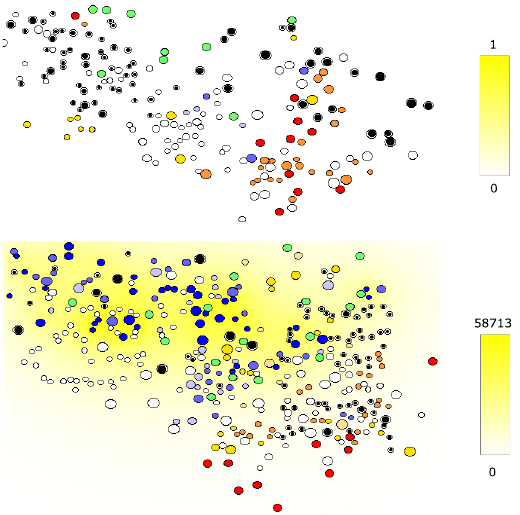
Figure 10. Snapshots of the simulation in which the concentration of FasL (in molecules/ µ L) is shown in yellow color gradient. For cell notations, the same color code as in Figure 7 is used. ( top ) Three days after the virus transmission; ( bottom ) 12 days after virus transmission.